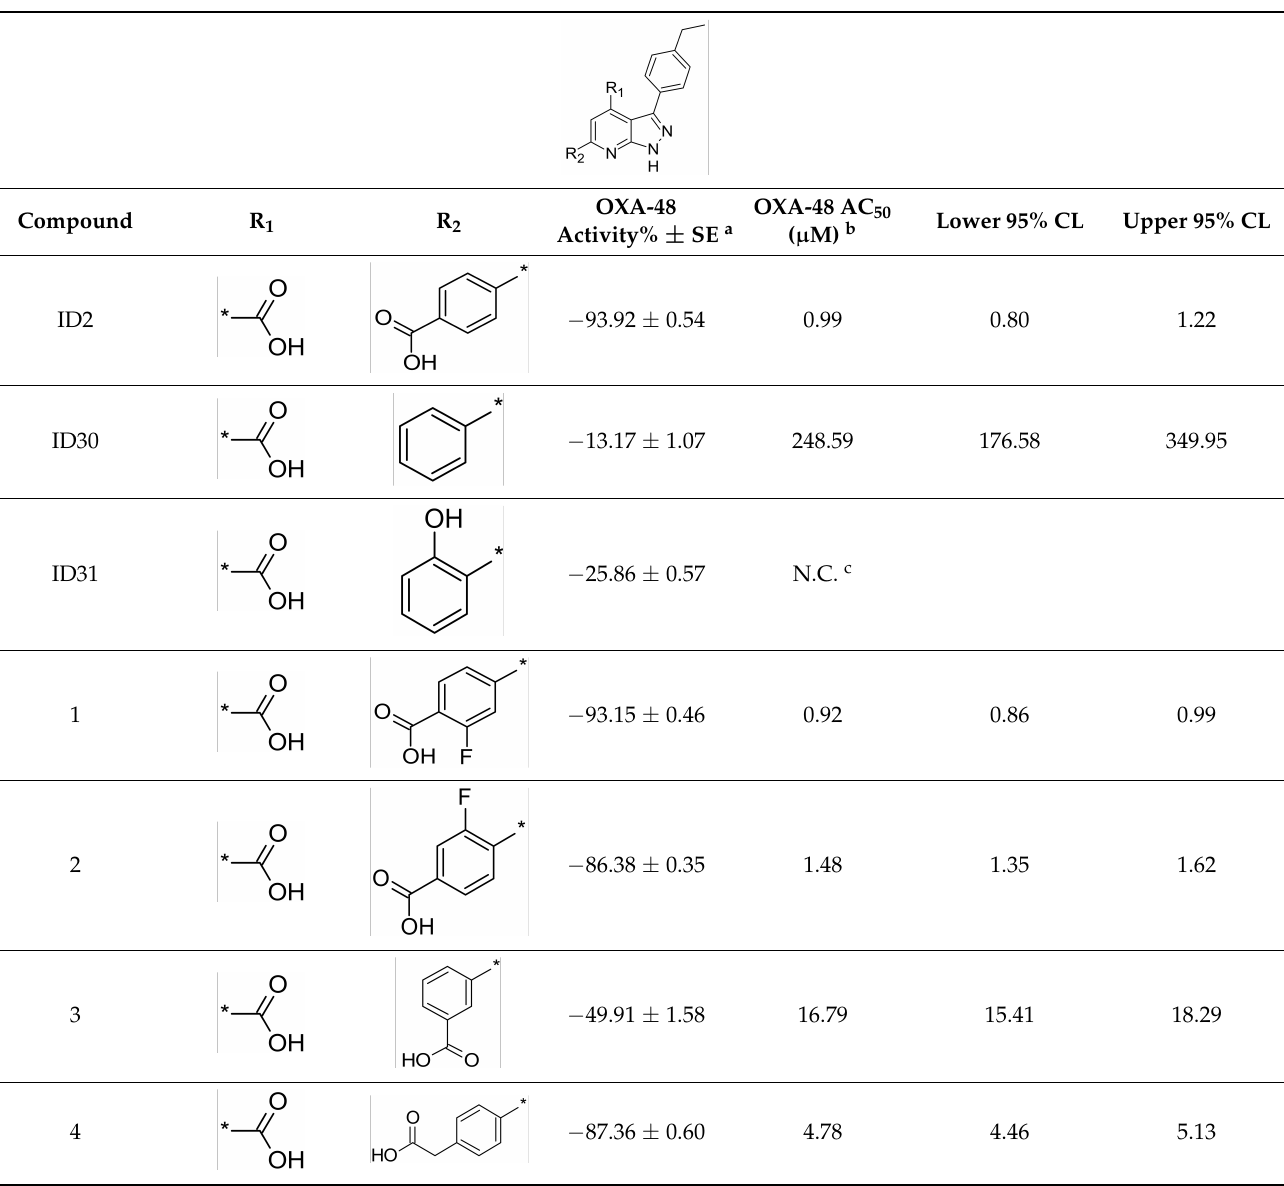
Table 5. SAR exploration at R1 and R2 positions of the pyrazolo[3,4-b]pyridine